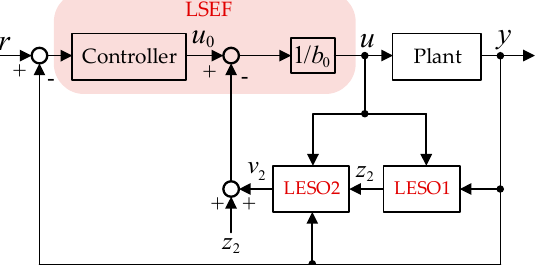
+ z v is jointly responsible for 2 2